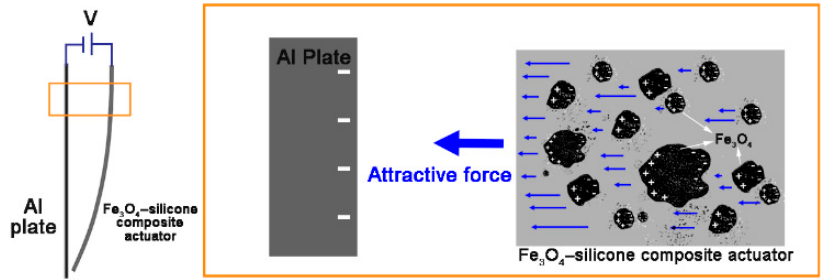
Figure 7. Surface of the aluminum plate (where the negative potential is applied) is conducted to the negative electrode. On the other hand, when a positive potential is applied to the actuator, the iron oxide particles near the top are conducted to the positive electrode. Thus, electrostatic attraction is generated, and the actuator moves.